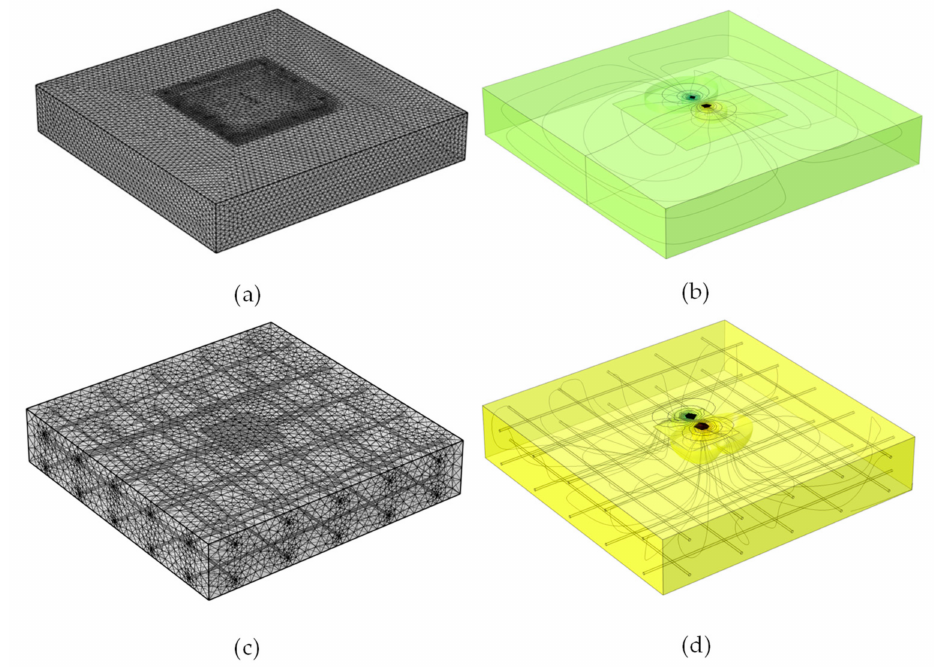
Figure 2. 3D finite element models for simulation of electrical field over a delamination defect in concrete: ( a , c ) finite element models for a plain- and a reinforced concrete slab, respectively; ( b , d ) electric potential field over a delamination defect in a plain- and a reinforced concrete slab,